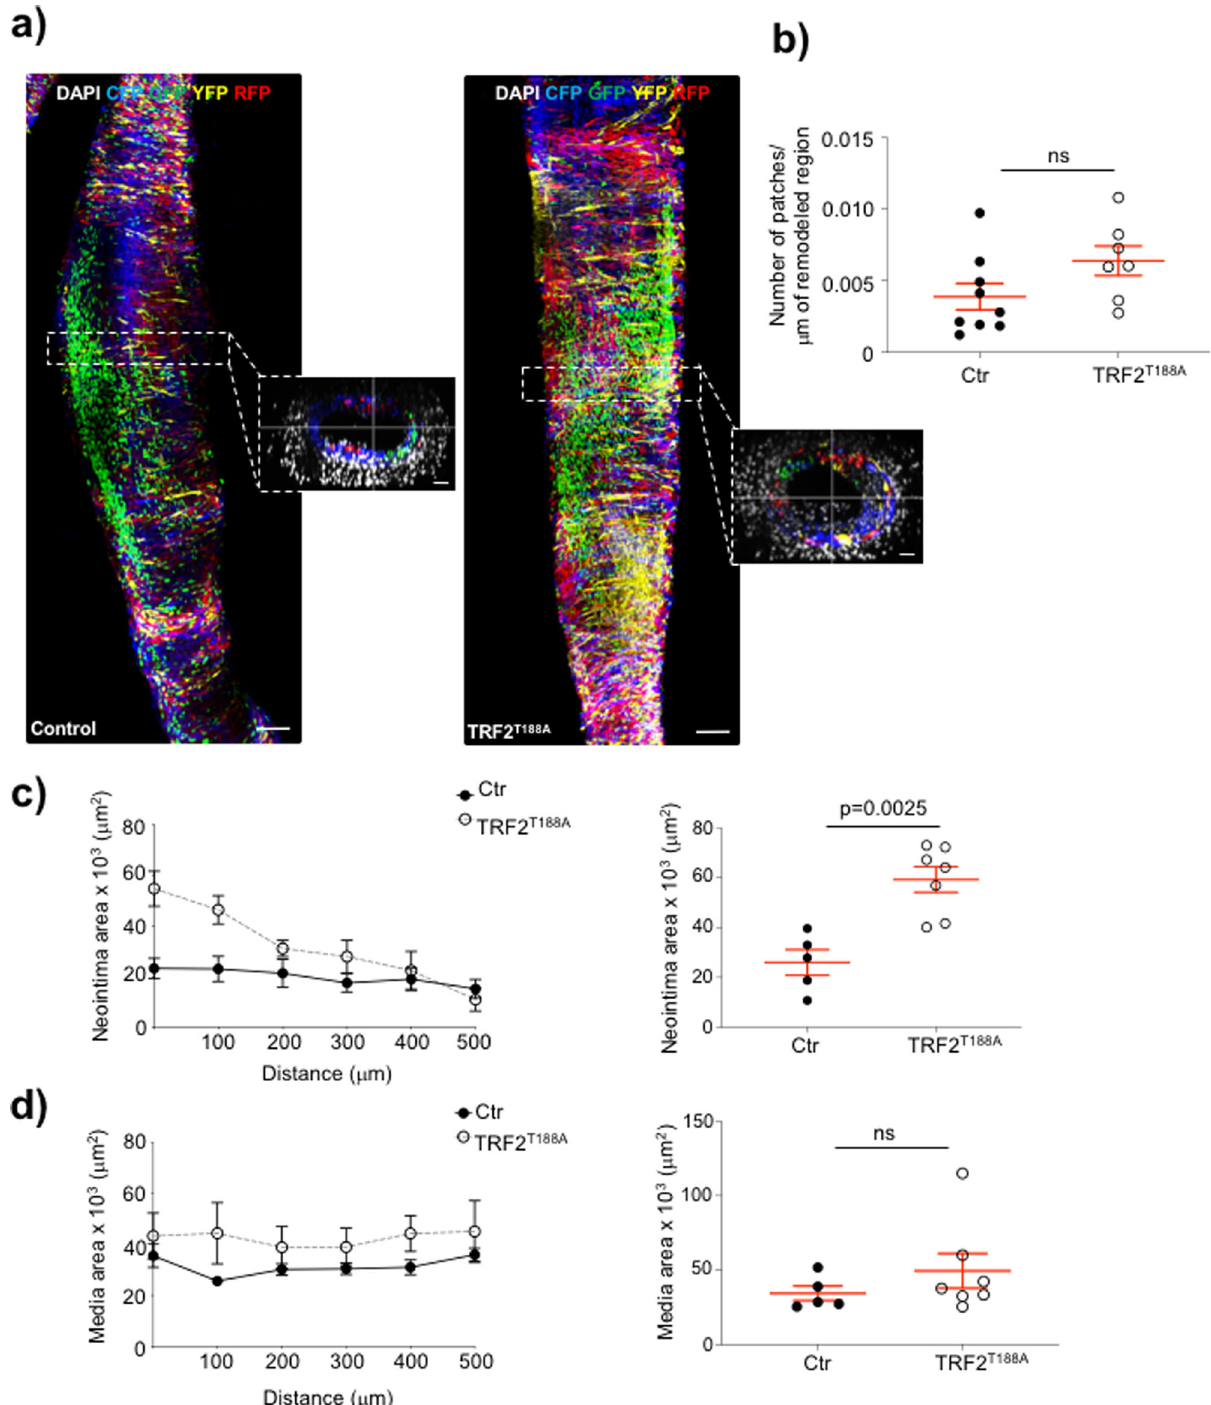
Fig. 5 Telomere damage promotes neointima formation with no change in VSMC clonality. a Whole-mount images of the left common carotid artery (LCCA) of SM22 α -TRF2 T188A /Myh11-Cre ERTM Rosa26-Confetti (TRF2 T188A ) mice and littermate controls (Ctr) 28d after carotid ligation. Images show maximum projection of the confocal Z-stack of the entire carotid artery and featuring CFP + , YFP + , GFP + , RFP + monochromatic patches. Outlined dotted regions represents cross-section. Scale bar = 100 μ m and 30 μ m (cross-section). b Number of monochromatic patches per μ m of the remodeled region. c Mean neointimal area measured over six serial sections 100 μ m apart or maximal neointimal area. d Mean medial area measured over six serial sections 100 μ m apart or maximal medial area. Data shown are means ± SEM, n ≥ 5 mice per group, ns-non signi fi cant ( p > 0.05), unpaired, two-tailed Student ’ s t test or Mann – Whitney U